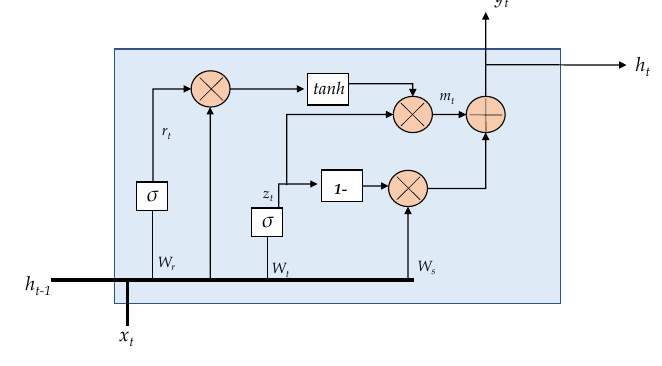
Figure 3. LSTM internal unit configuration.